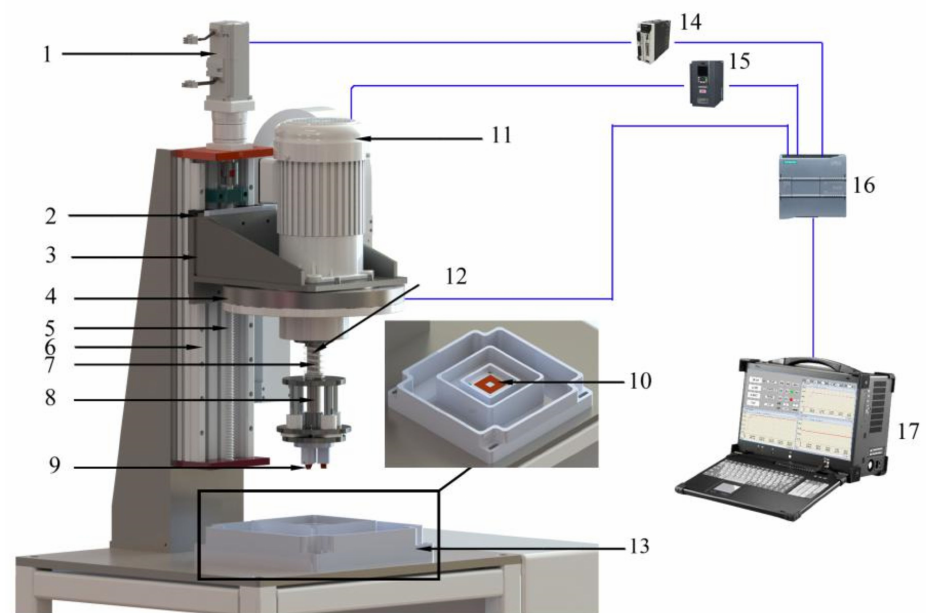
Figure 4. Schematic diagram of the friction and wear tester that can simulate the complex working conditions of a coal mine [17]: (1) Servo motor, (2) Slider, (3) Loading flange, (4) Positive-pressure detection mechanism, (5) Screw, (6) Linear guide rail, (7) Spring, (8) Grinding head mechanism, (9) Upper samples, (10) Samples, (11) Frequency conversion motor, (12) Spindle, (13) Corrosion chamber, (14) Servo driver, (15) Frequency converter, (16) Programmable logic controller, (17) Princi- pal